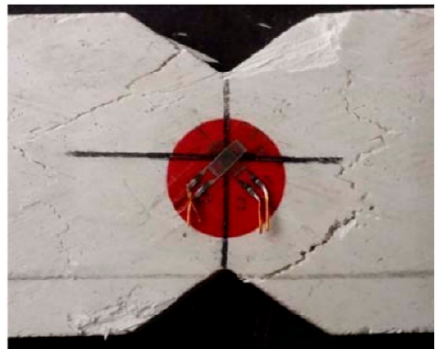
Figure 12. Crack growth in an Iosipescu test sample with fiber orientation of ±22.5° in the case of WHIPOX™ [30]. WHIPOX ™